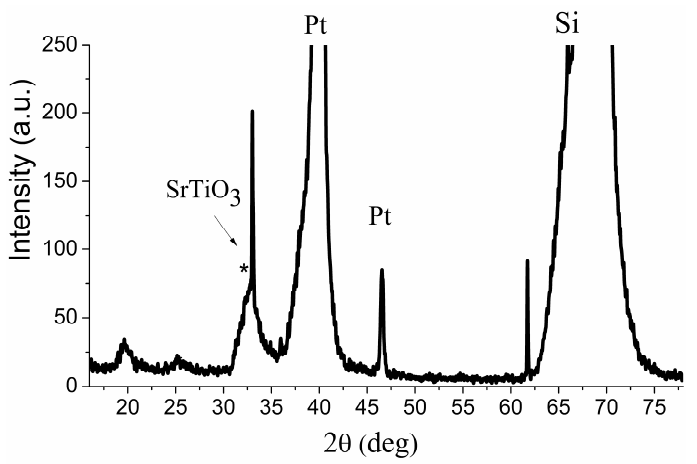
Figure 5. XRD spectra of Si/TiO x /Pt/SrTiO 3 /Ni heterostructure.